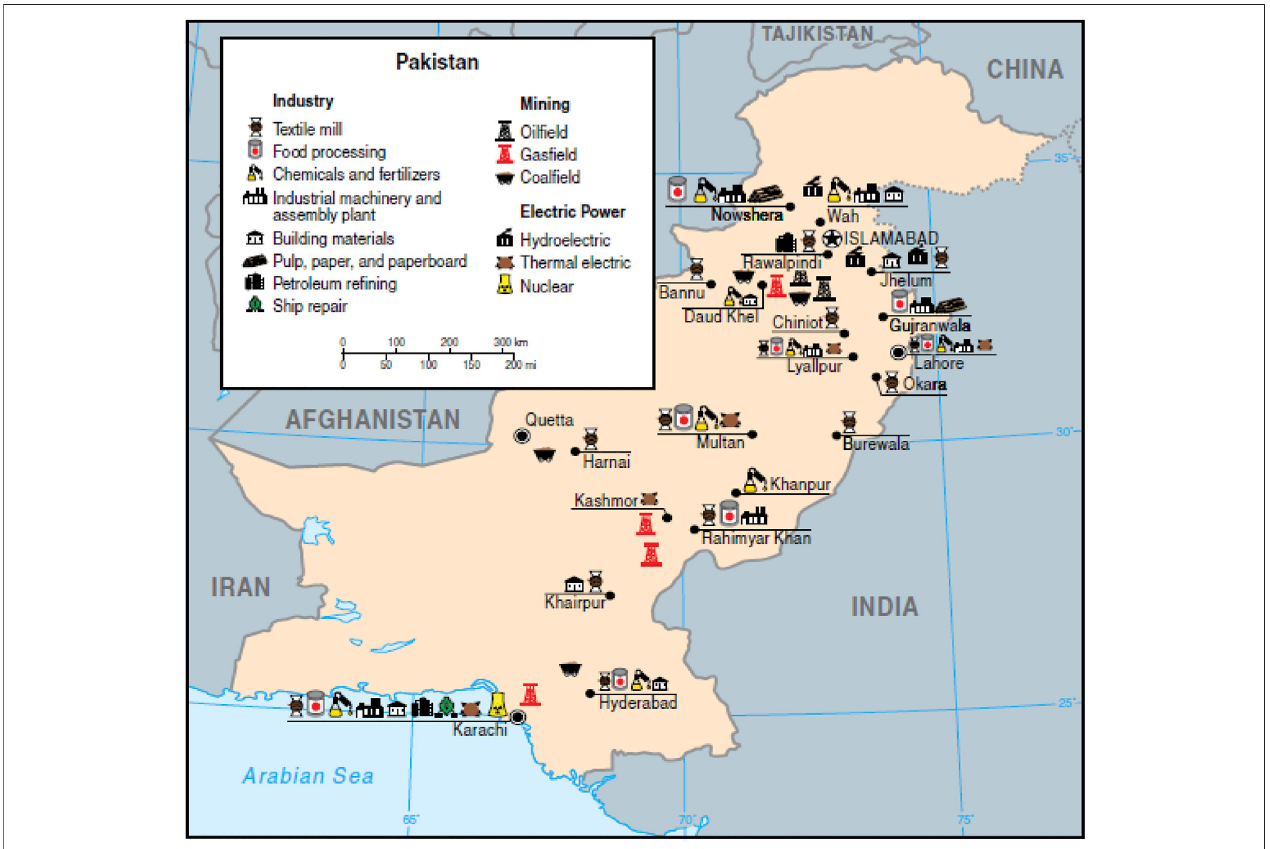
FIGURE 1 | Crude, gas, and coal production of